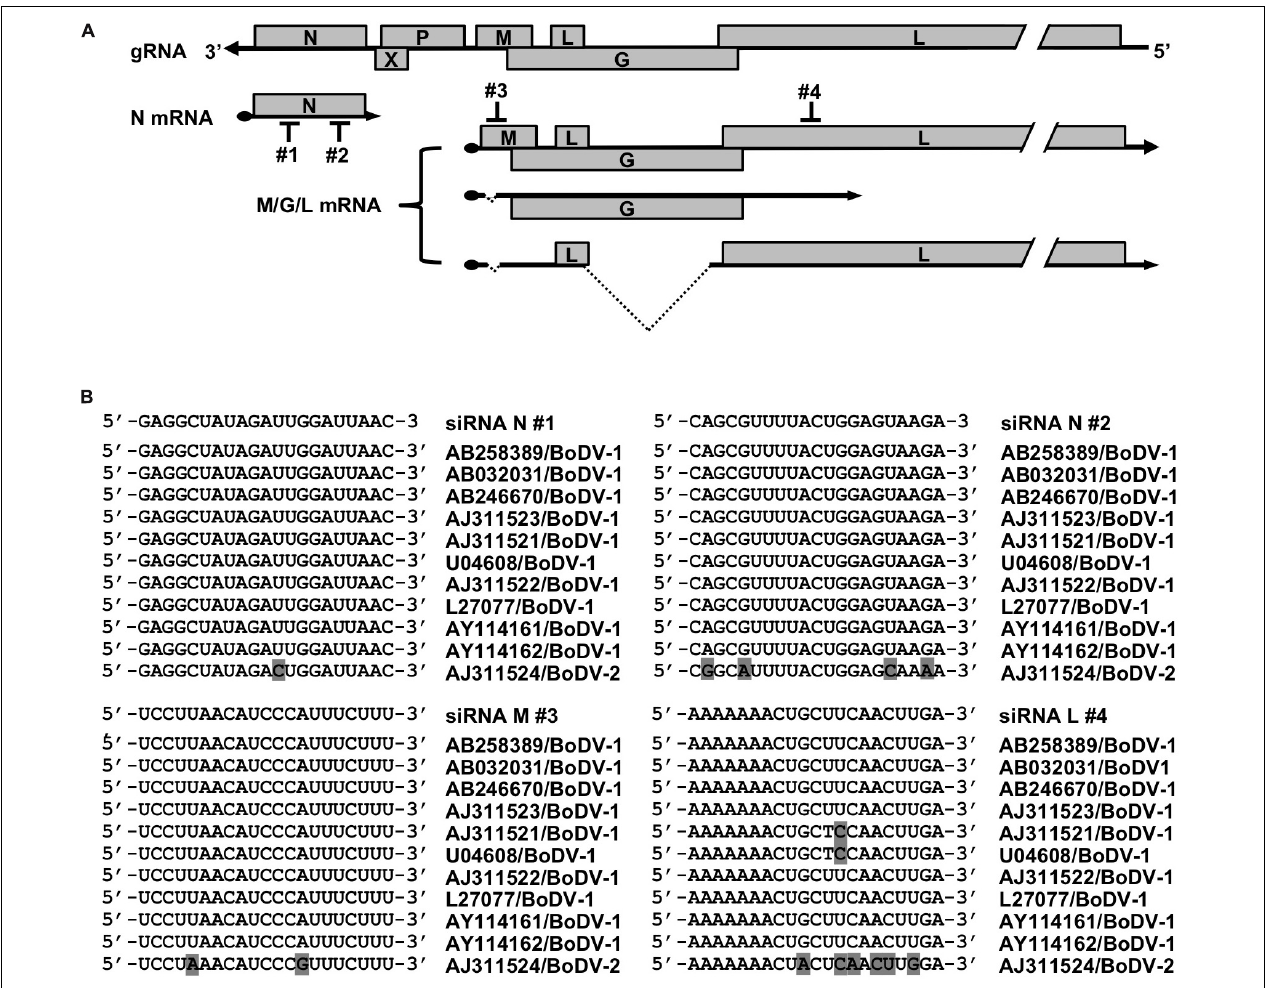
FIGURE 1 | siRNAs designed to target BoDV-1 genes. (A) Schematic view of the BoDV-1 genome and mRNAs with the designed siRNAs. (B) Alignment of the siRNA target sequences and the mRNA sequences of various BoDV-1 and BoDV-2 strains.